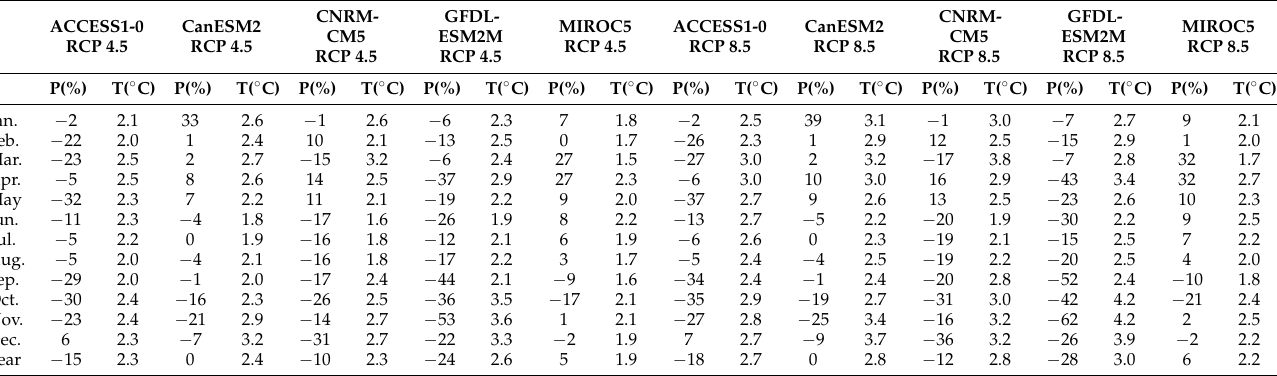
Table 4. Change of rainfall (P, %) and temperature (T, ◦ C) as projected by the climate models under different scenarios in